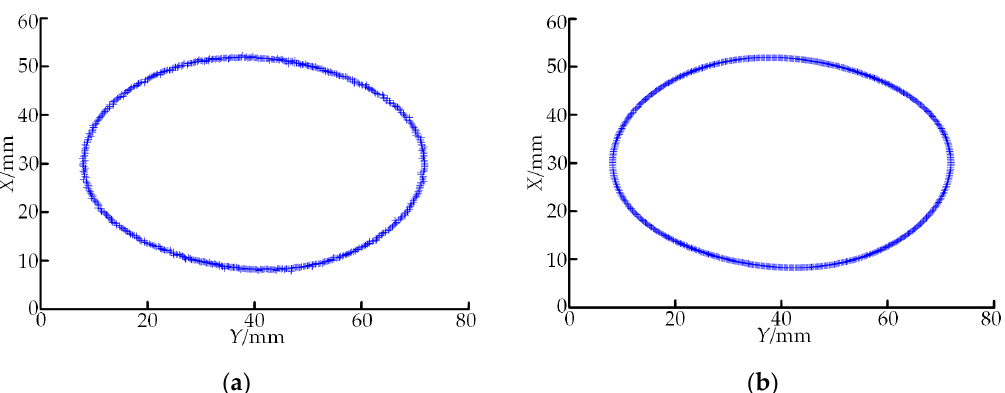
Figure 12. Profile data of double-headed screw rotor . ( a ) Original profile data acquired through the method in Section 2.1; ( b ) profile data denoised through the method in Section 2.2.